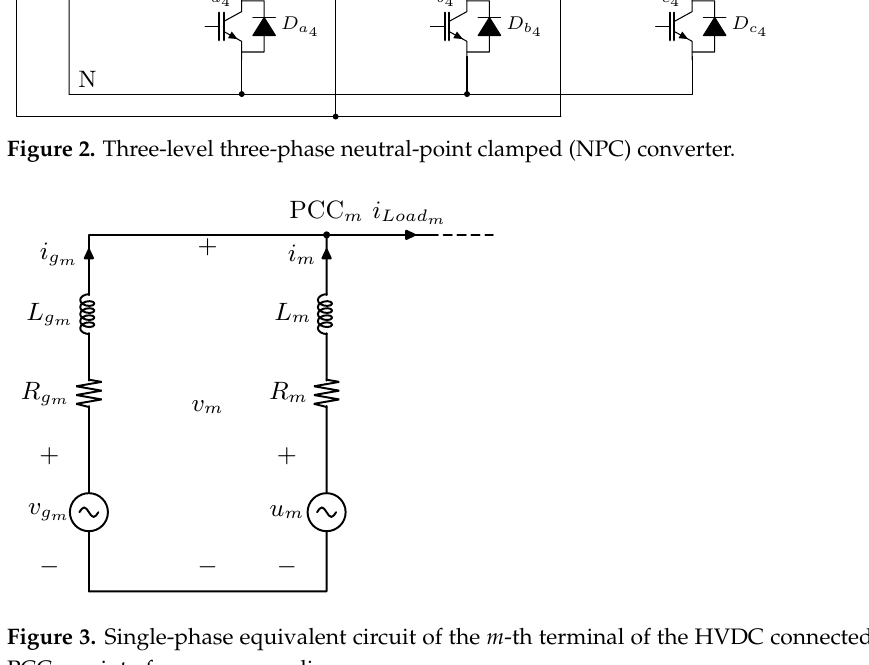
Figure 3. Single-phase equivalent circuit of the m -th terminal of the HVDC connected to the grid. PCC—point of common